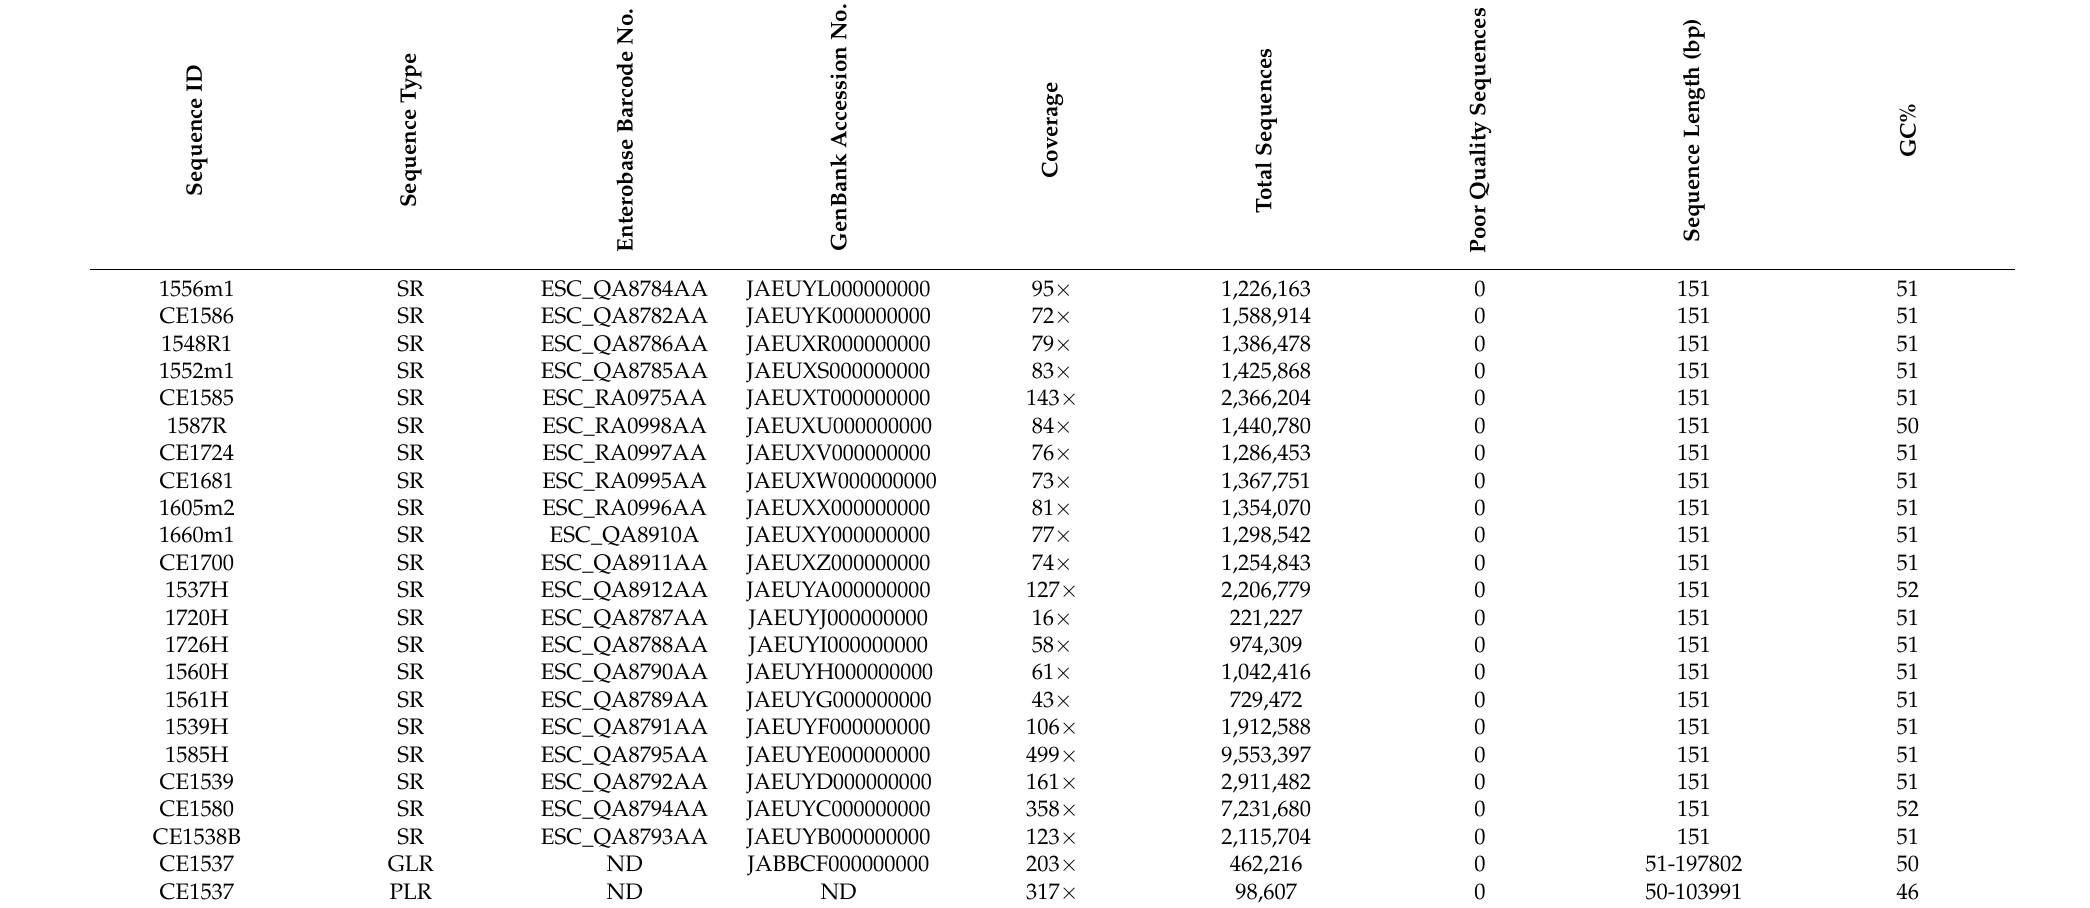
Table 1. Escherichia coli ST216 short read and long read sequences, metadata and quality control